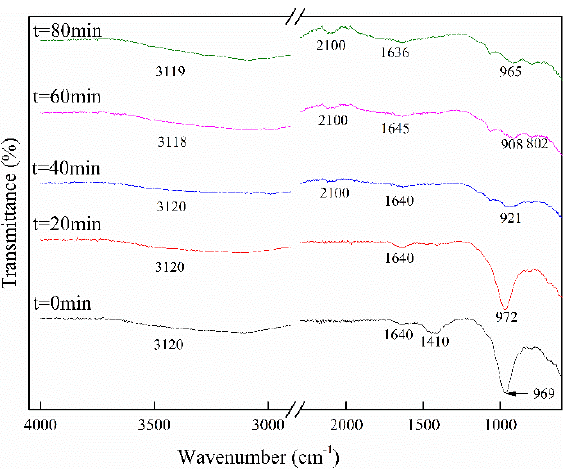
Figure 10. Infrared spectrum of the raw red mud desulfurization process.